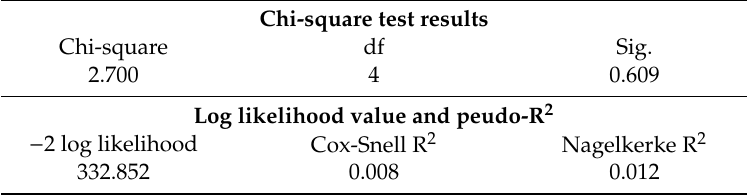
Table 6. Test results and log likelihood value and pseudo-R 2 for the model of the risk of a high share of foreign capital.